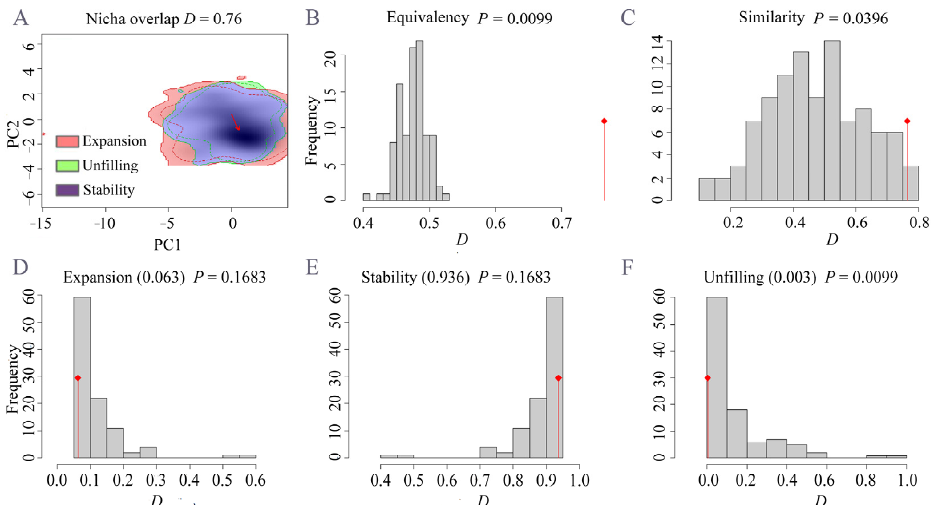
Figure 7. Niche comparison for Phoracantha semipunctata between native (Australia) and invasive areas. ( A ): niche overlap on two principal component axes (PC1 and PC2). ( B , C ): equivalency and similarity tests. ( D – F ): niche expansion, stability, and unfilling tests. Red lines in the plots indicate the observed value of niche overlap, and gray bars indicate the distribution of D values for 100 simulated comparisons.